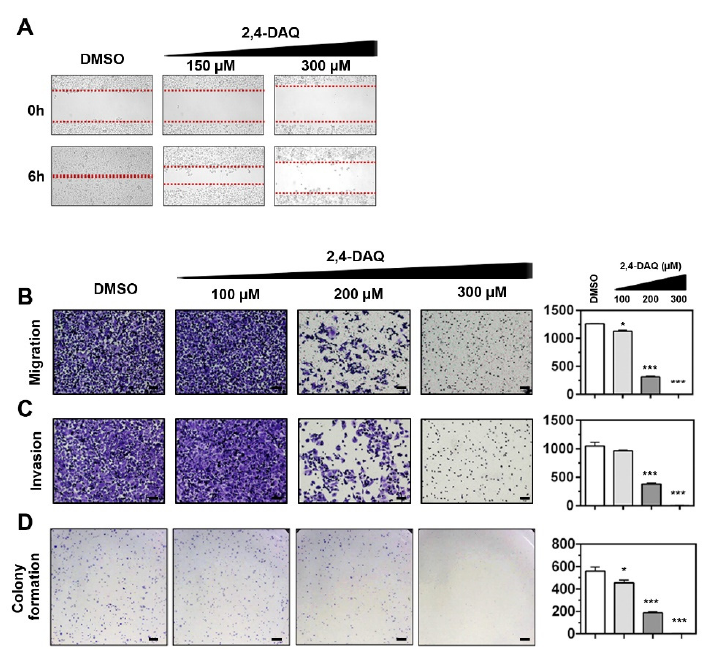
Figure 4. 2,4-DAQ modulates the colony formation, migration and invasion abilities of AGS cells. The gastric cancer cells were treated with different concentrations of 2,4-DAQ or control (DMSO) and ( A ) processed for wound-healing assay. ( B ) Transwell migration assay (without Matrigel); ( C ) invasion assay (with Matrigel); ( D ) colony formation assay. Data presented as mean with error bars representing SD (* p < 0.05; *** p < 0.001). Scale bar: 100 μ m.